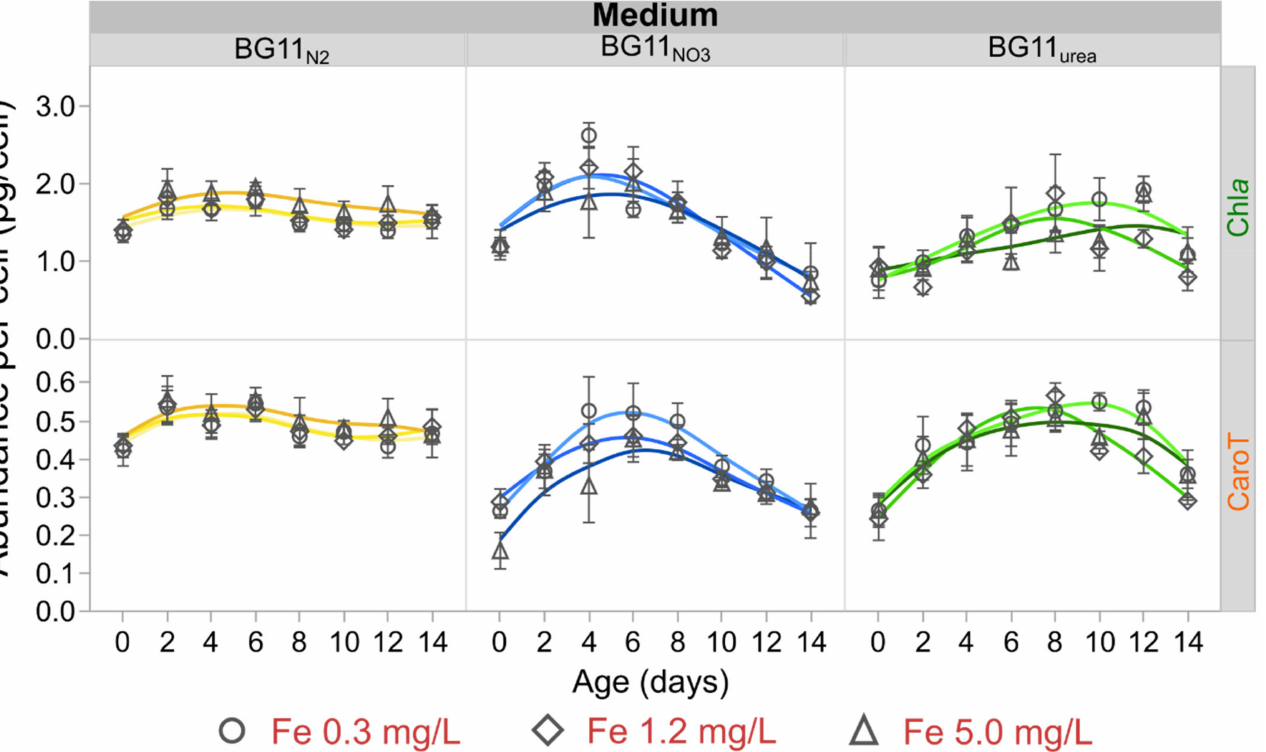
Figure 3. Relative abundance of Chlorophyll a (Chl a ) and total carotenoids (CaroT) per cell. Chl a and CaroT profiles were constant in diazotrophic cultures, showing steady production of hydrophobic pigments until the end of the experiment. Non-diazotrophic cultures in BG11 NO3 and BG11 urea media presented maximum values of Chl a and CaroT abundance per cell during their exponential phase. Markers represent average values of three independent replicates and error bars are constructed using one standard error from the